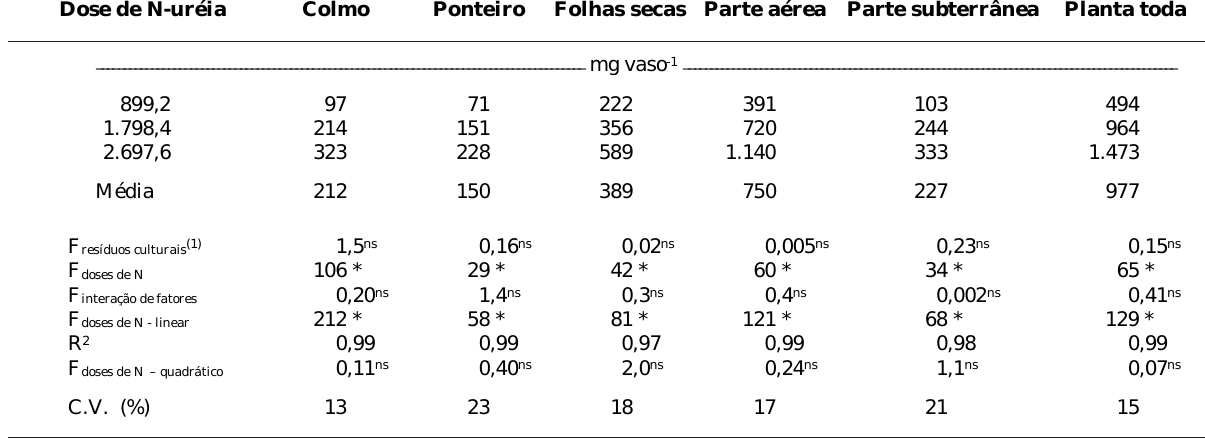
N-uréia N-outras fontes